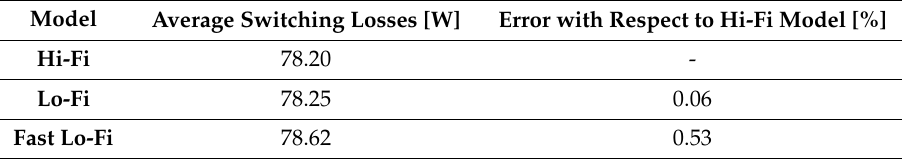
Table 5. Average switching power losses in the Hi-Fi, Lo-Fi, and Fast Lo-Fi models.